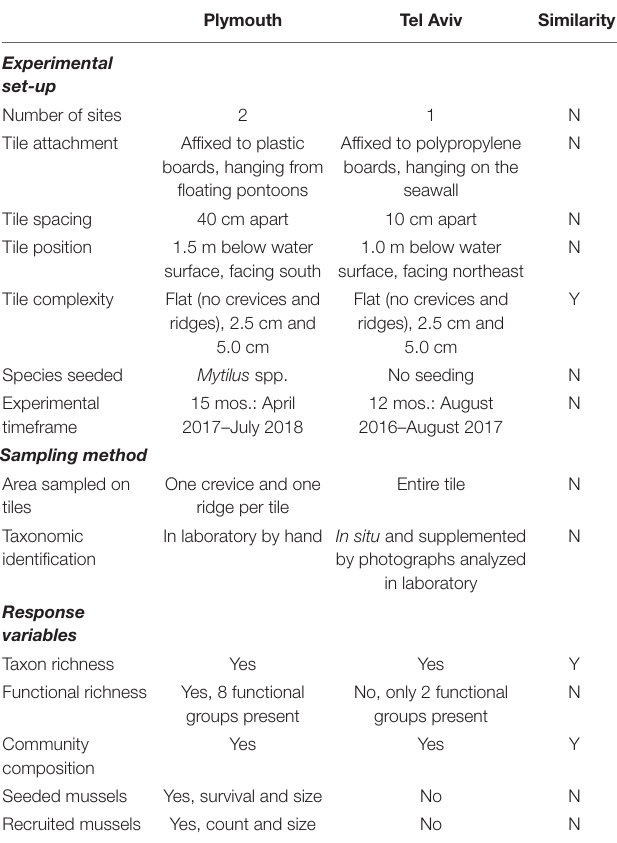
TABLE 1 | Comparison of experimental set-up, sampling methods, and response variables measured in experiments testing effects of physical and